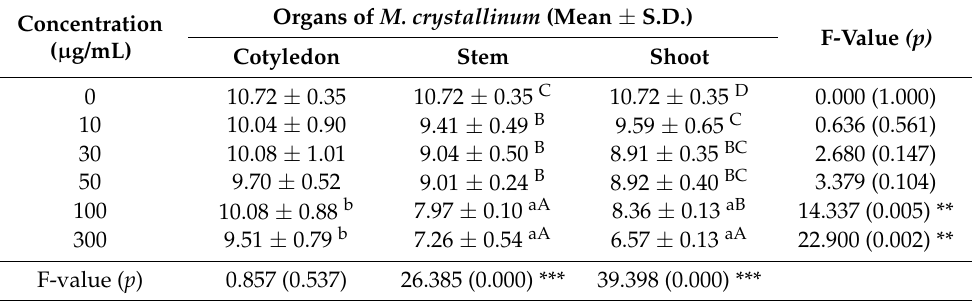
Table 7. Effects of ethanol extract according to each ice plant organs on the IL-6 levels in LPS-induced RAW 264.7